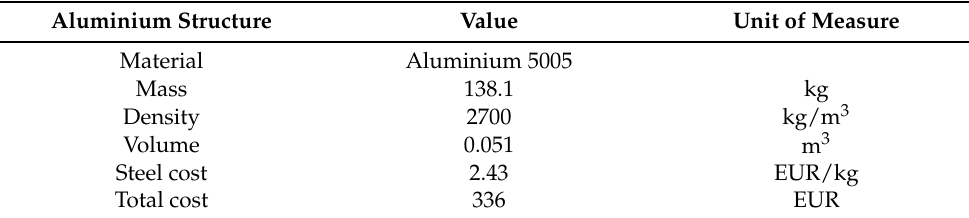
Table 6. Aluminium frame cost